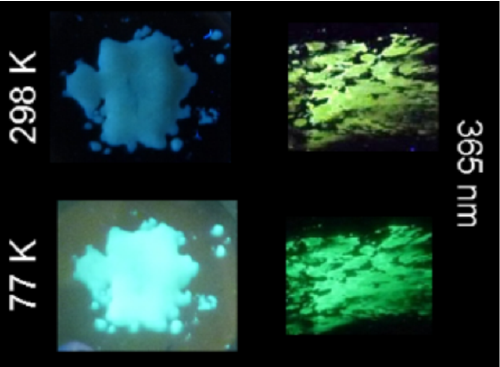
Figure 11. Photos of 24 under 365 nm (UV lamp) before and after grinding at 298 and 77 K. Reprinted (adapted) with permission from Chem. Mater. 2016, 28, 22, 8190–8200 (ref. [59]). Copyright 2016 American Chemical Society.